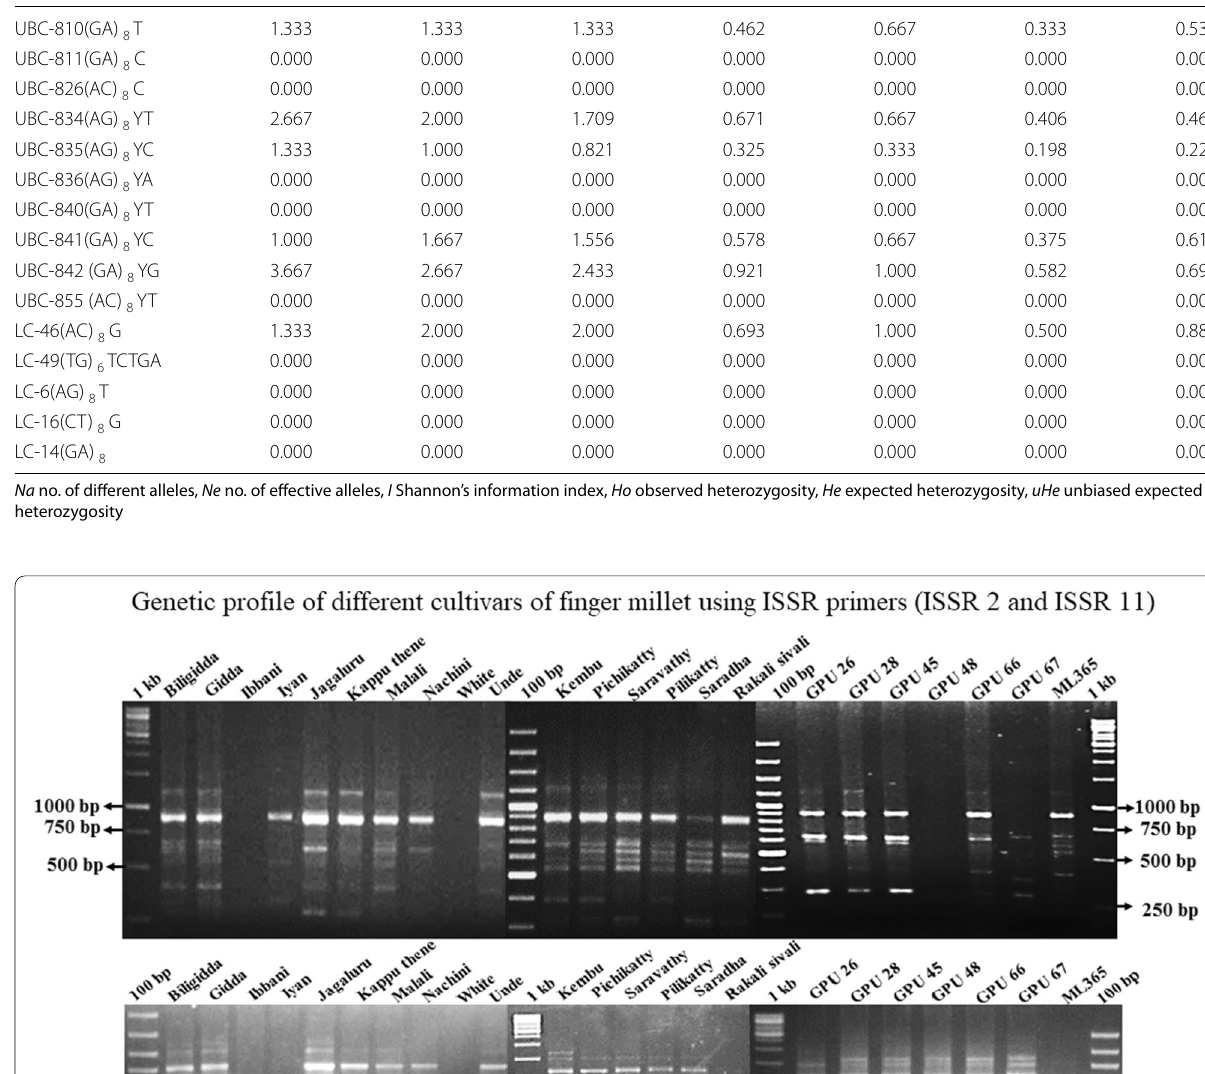
Table 3 Marker parameters like levels of effective alleles, Shannon’s information index, observed heterozygosity, expected heterozygosity, and unbiased expected heterozygosity value for 23 finger millet varieties Primer code N